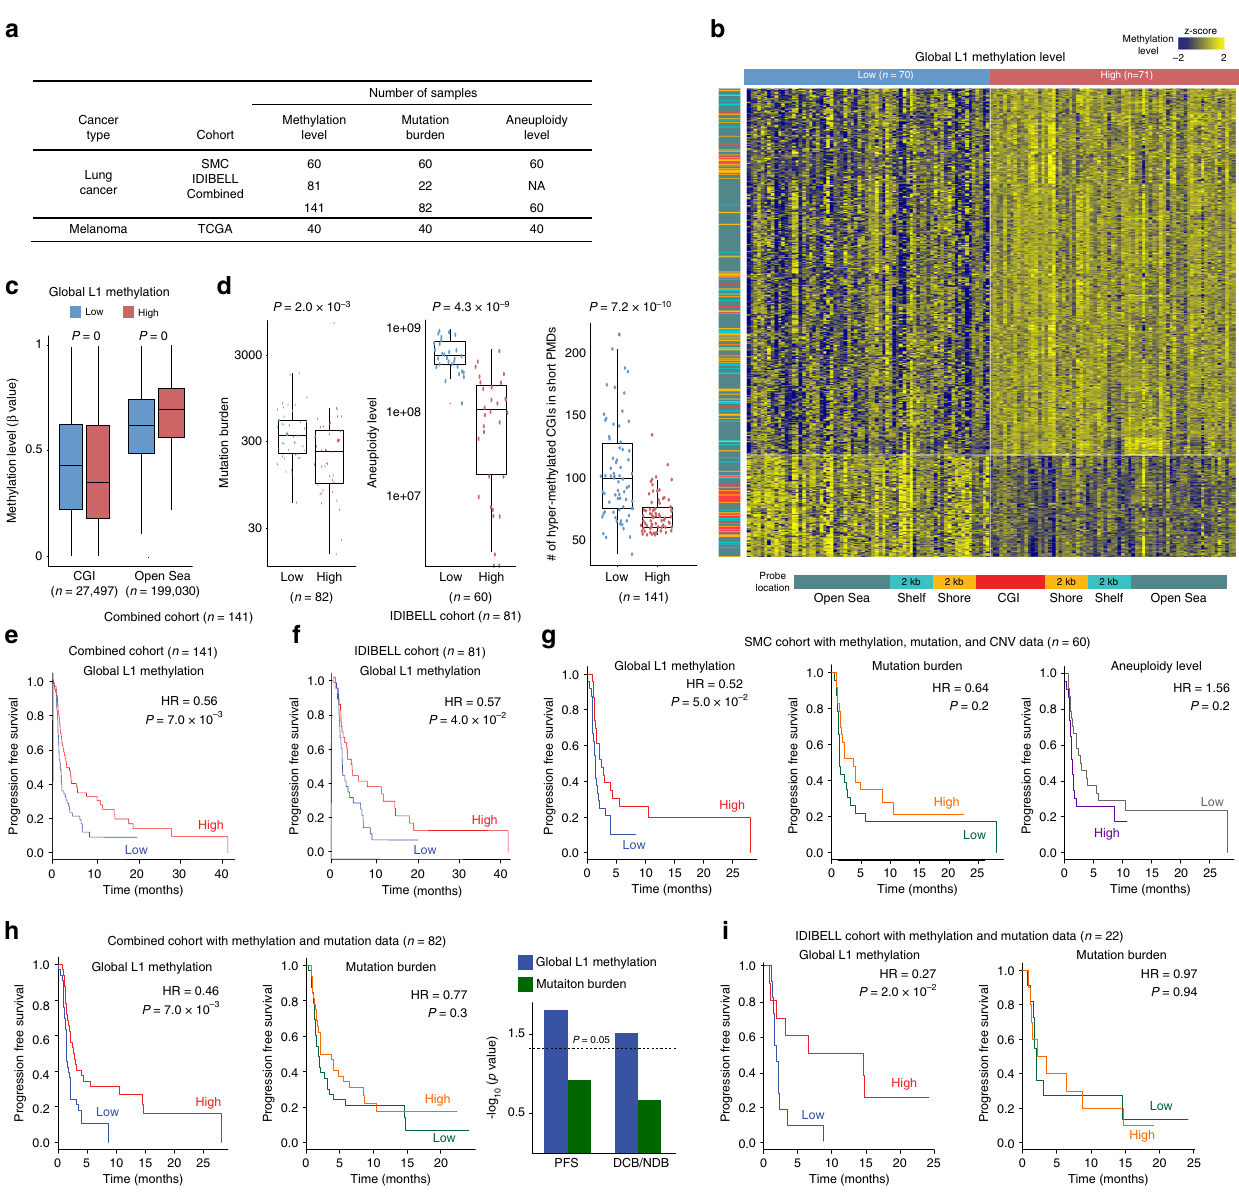
Fig. 5 Genomic demethylation adversely affects the clinical bene fi t of checkpoint blockade. a Summary of immunotherapy cohort samples with available data. b Unsupervised hierarchical clustering of the DNA methylation pro fi les of the SMC lung cancer cohort samples. The methylation probes (row) were clustered and samples (column) were divided into two groups according to the median of the global methylation level. The heatmap shows beta values for the most differentially methylated loci (the highest 1%) between tumour samples with low and high global methylation. The methylation probes were categorized by the relative distance from CGIs (CGI, shore, shelf, and open sea). c Differential CGI/open-sea methylation between the global low and high groups. The differentially methylated loci between the two groups (FDR <0.05) were selected, and per-locus beta values were averaged for each group. The paired t-test was used to test the statistical signi fi cance. d Comparison of mutation burden, the aneuploidy level, and the number of hyper-methylated promoter CGIs in the short PMDs between tumour samples with low and high global methylation. e , f Survival analysis using tumour samples with methylation data from the e combined or f IDIBELL cohort. Patients were strati fi ed by the global L1 methylation level. The log rank test was used to compare survival curves estimated by the Kaplan – Meier method. g Survival analysis using the SMC tumour samples with methylation level, mutation burden, and aneuploidy level. Patients were strati fi ed by the global L1 methylation level (left), mutation burden (middle), and the aneuploidy level (right). h Survival analysis using tumour samples with methylation and mutation data from the combined cohort. Patients were strati fi ed by the global L1 methylation level (left) or mutation burden (middle). To estimate the relative contribution of mutation burden and global methylation to patient survival and clinical bene fi t, the multivariate Cox proportional hazards model (for PFS: progression free survival) or multivariate logistic regression model (for DCB: durable clinical bene fi t and NDB: no durable bene fi t). i Survival analysis using the IDIBELL tumour samples with methylation and mutation data. Patients were strati fi ed by the global L1 methylation level (left) or mutation burden